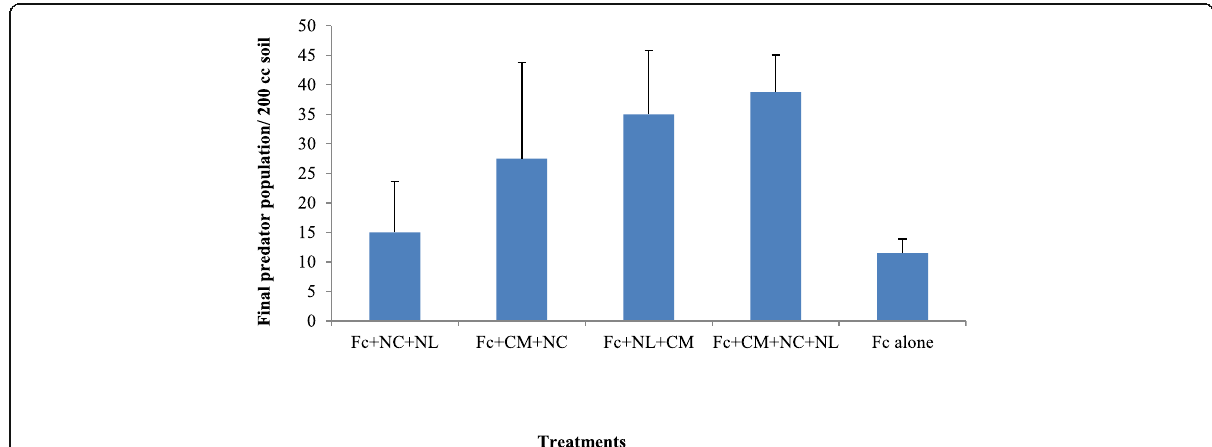
Fig. 4 Final population of Fictor composticola in presence of different combinations of organic amendments (NC, neem cake; CM, chicken manure; NL, neem leaves; Fc, F. composticola